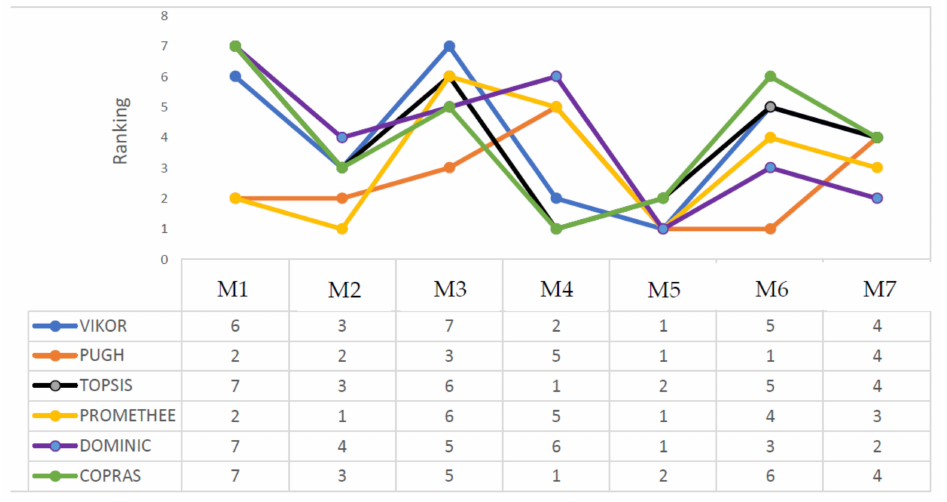
Figure 4. Comparison of MCDM